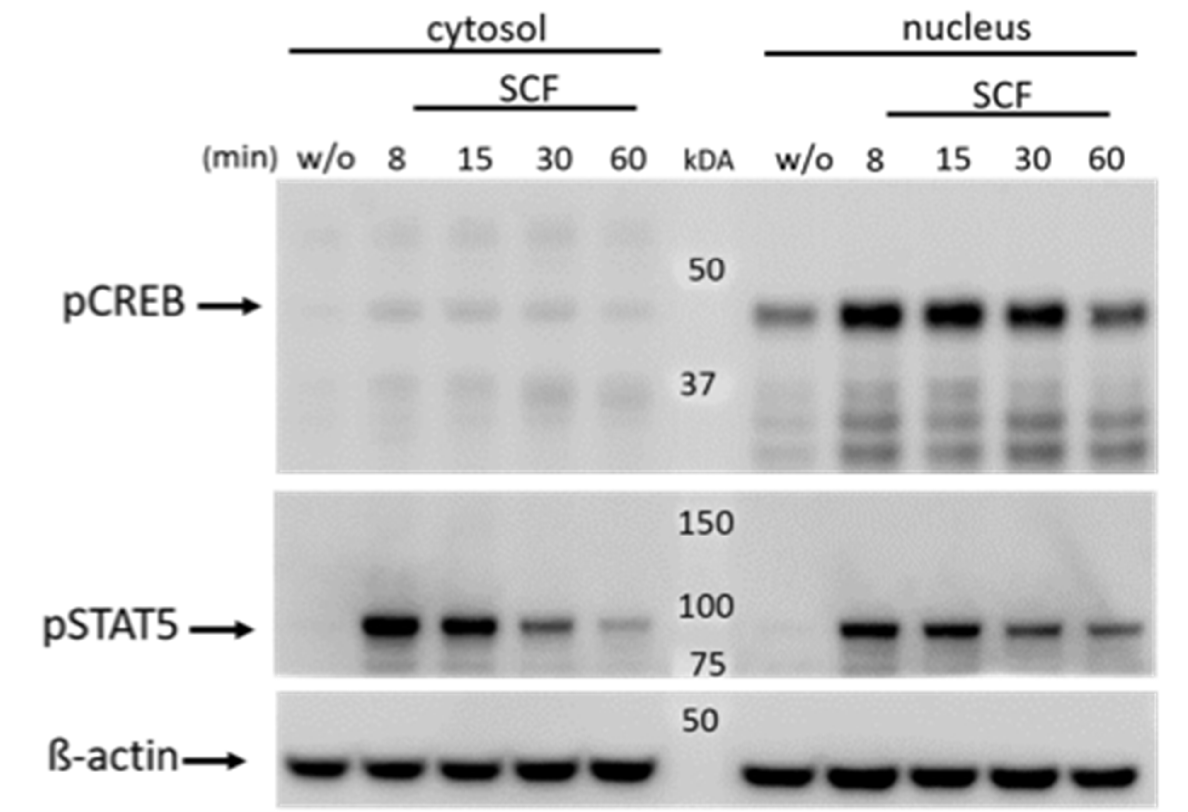
Figure 3. CREB is constitutively located in the nucleus where phosphorylation occurs. MCs were treated with SCF for the times given, cytosolic and nuclear fractions were prepared separately and phosphorylation events were detected by immunoblot. Upper panel: CREB phosphorylated on Ser ‐ 133. Center: STAT5 phosphorylated on Tyr ‐ 694 given for comparison. Lower panel: β‐ actin (loading control). One of three experiments with comparable outcomes is shown. For total versus phosphorylated STAT5 and CREB, please refer to Figure S4.